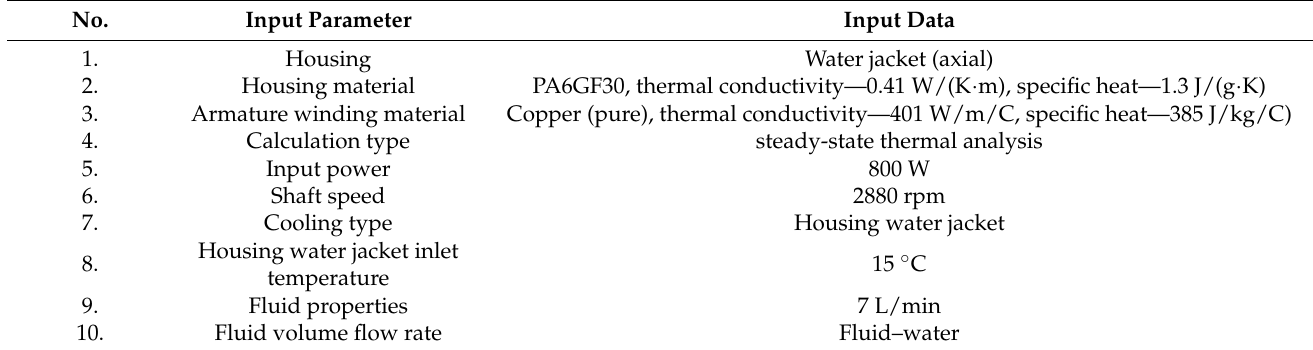
Table 14. Input parameters for thermal analysis of water-cooled motor with PA6GF30 casing.